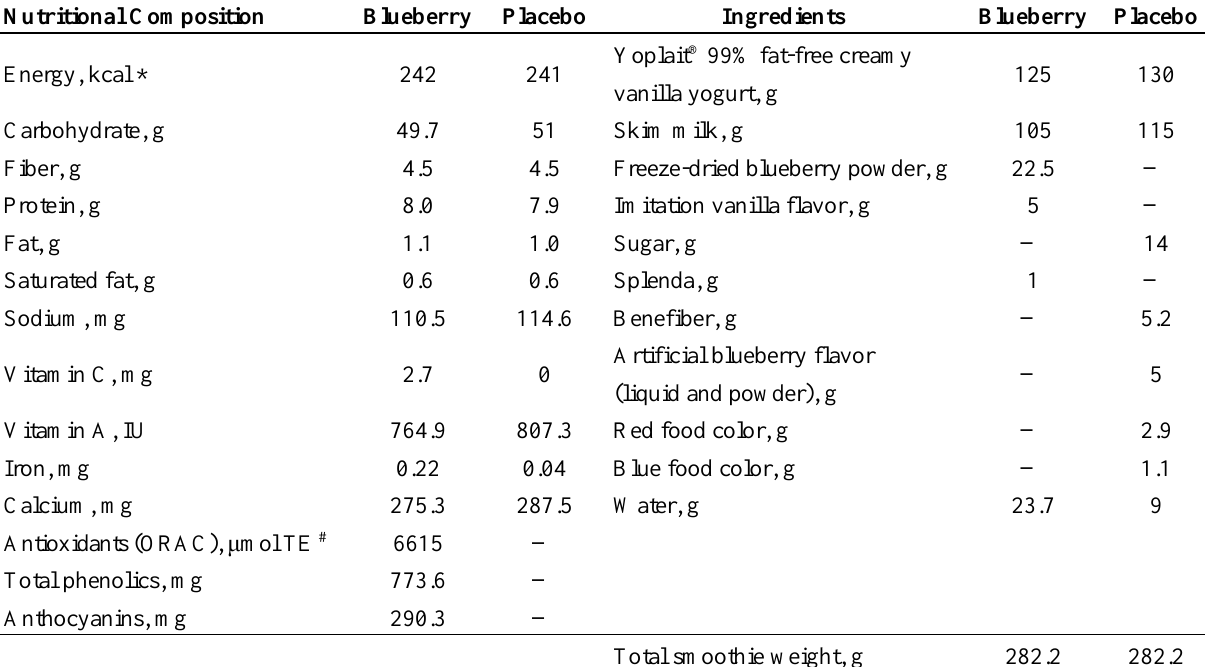
Table 1. Nutritional composition and ingredients in the